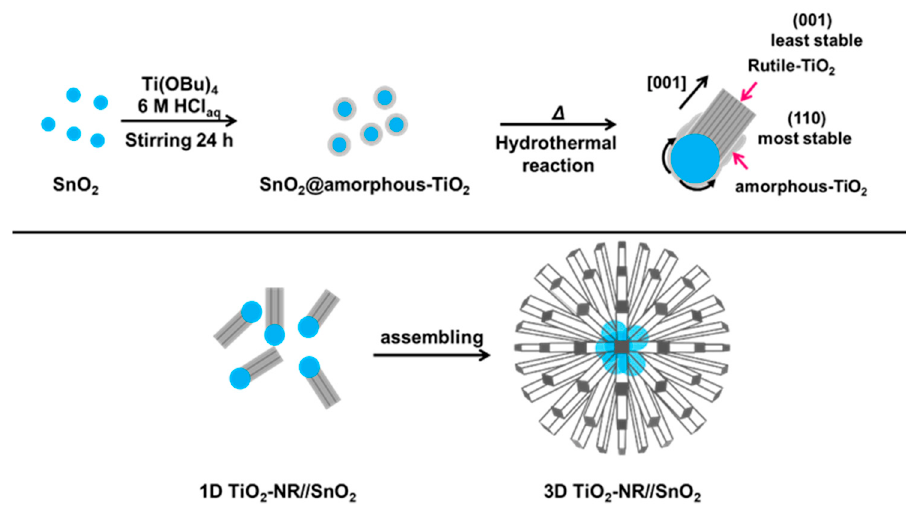
figure is taken from Reference [14] (reproduced with permission from Akita, A.; Tada, H., Lang ‐ muir ; published by American Chemical Society,